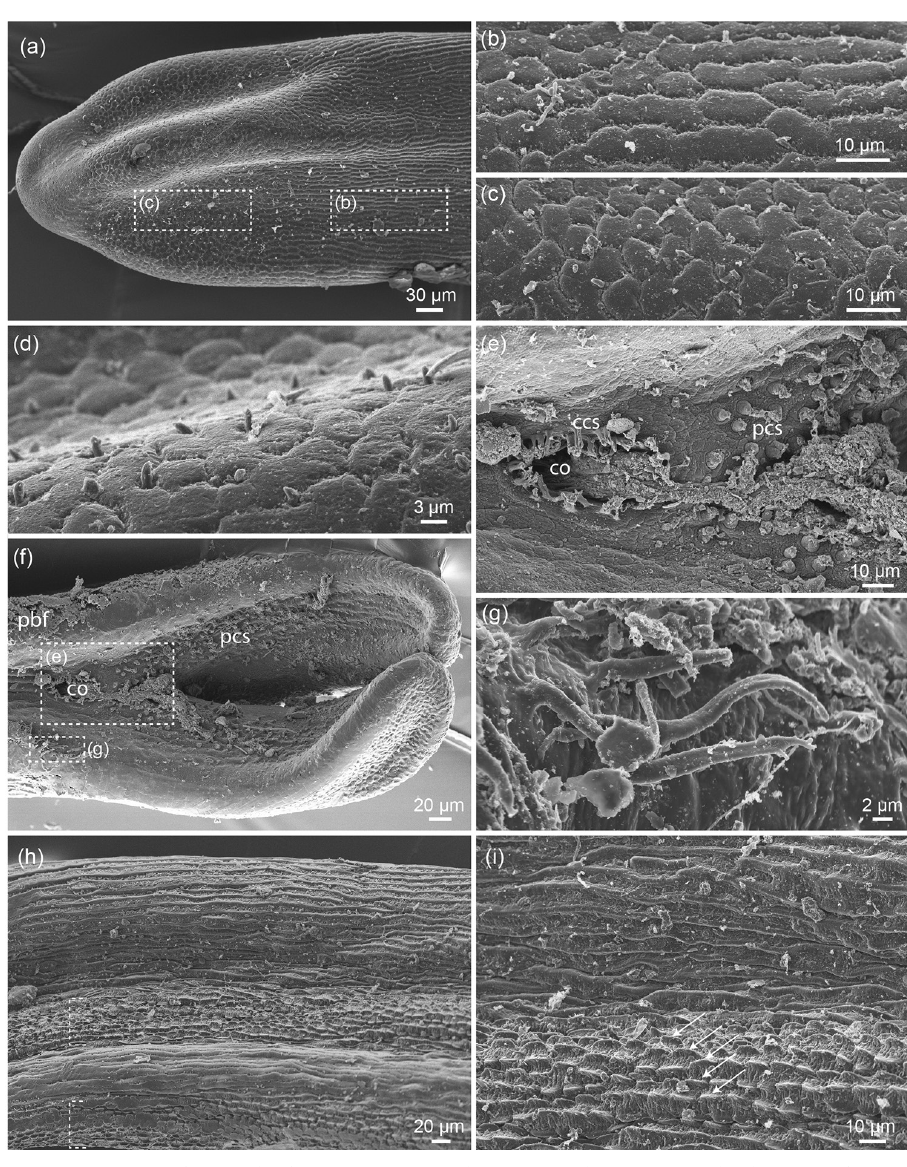
Figure 2. Beatogordius nagalandis sp. n., anterior and posterior end: a anterior end in low magnification, approximate positions of images b and c are indicated b, c transition of “bands” into areoles in two dif- ferent regions as indicated in fig. a d fine spines are present between areoles in the anterior end e region of the cloacal opening ( co ) with circumcloacal spines ( ccs ) and postcloacal spines (pcs) f ventral view on posterior end with cloacal opening ( co ), postcloacal spines ( pcs ) and precloacal bristle fields ( pbf ). Approximate positions of images e and g are indicated by dotted rectangles g some bristles from the pre- cloacal bristle fields h position of the broad rows of keeled structures (see dashed markings) on the ventral side of the animal i magnification of keeled structures